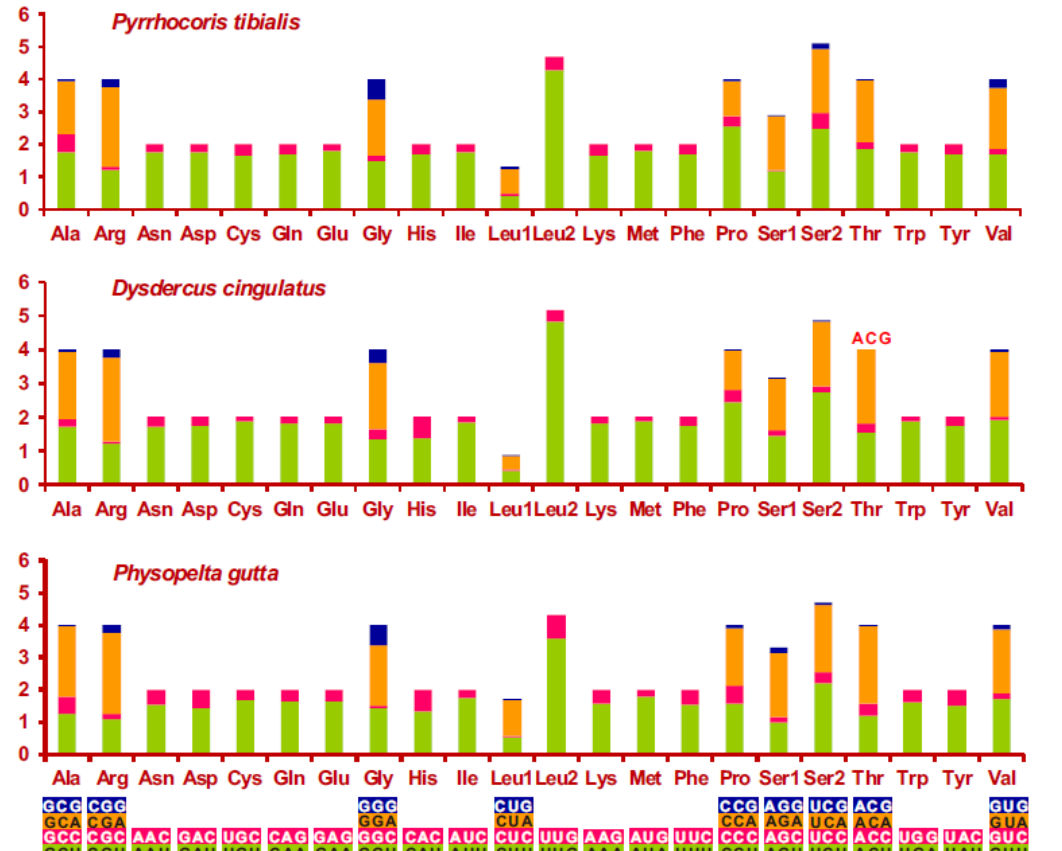
Figure 3. Relative synonymous codon usage (RSCU) in the mitochondrial genomes of three Pyrrhocoroidea species. Codons that are not present in the genome are indicated in red. Codon families are provided on the X -axis. RSCU: Ratio of the actual number of synonymous codons used to translate specific amino acids to the expected number. When the observed values of synonymous codons are the same as the expected values, RSCU = 1, and the codons are not biased. When RSCU > 1, the codons are positively biased. When RSCU < 1, the codons are negatively biased.